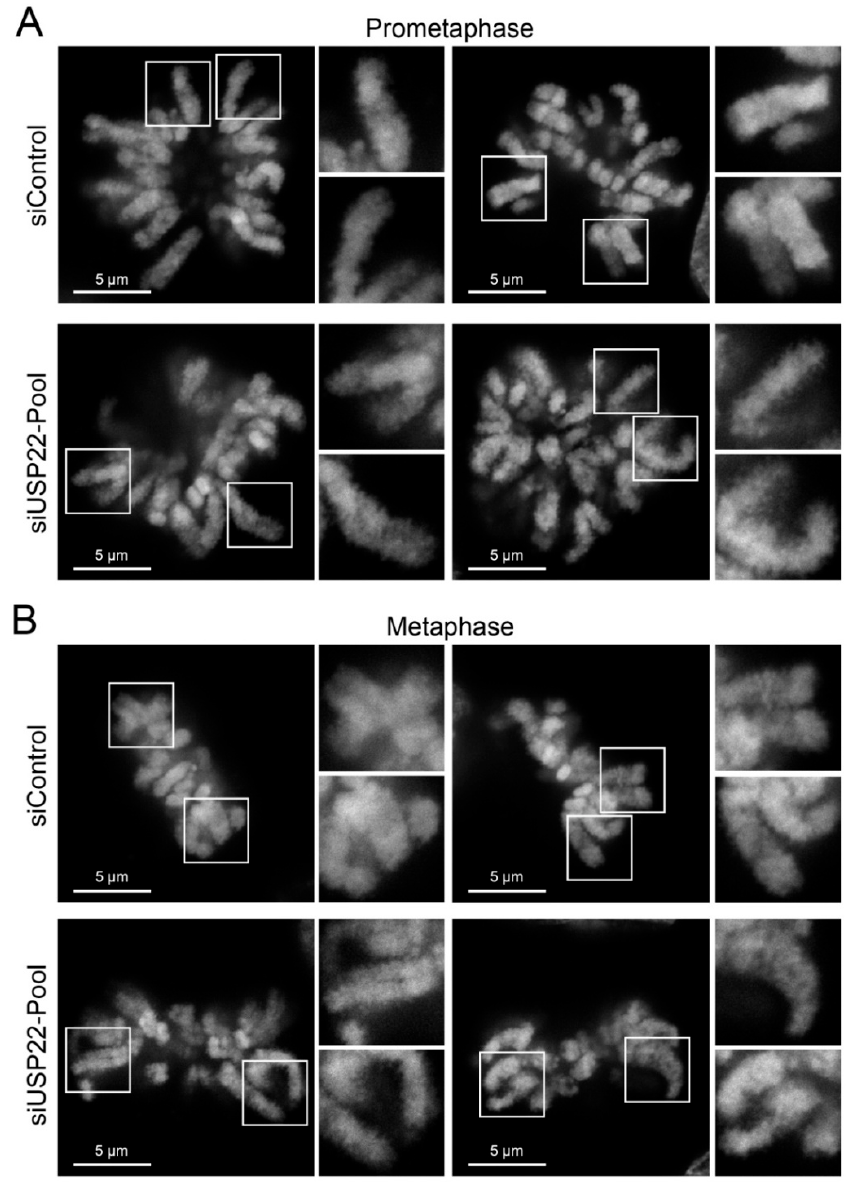
Figure 2. USP22 silencing induces chromatin compaction defects in mitotic HCT116 cells. ( A ) Representative STED images of prometaphase chromosomes from siControl (top) and USP22 -silenced conditions (bottom). White bounding boxes identify the magnified regions presented in the right-hand panels. Note the less dense and more granular staining patterns present within the USP22 -silenced conditions, which are indicative of chromosome compaction defects. ( B ) STED images comparing chromosome compaction within siControl (top) and USP22 -silenced (bottom) metaphase cells with similar differences in staining patterns (density and granularity) to those indicated above.